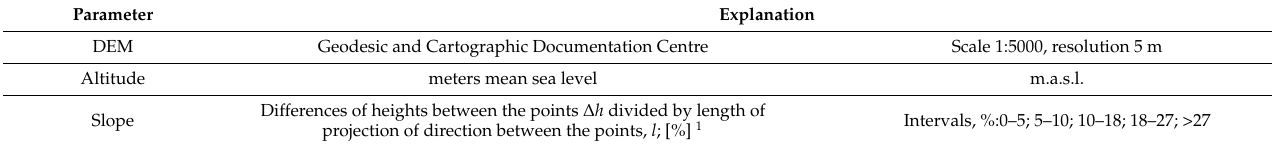
Table 1. Description of parameters used in coefficient wetness model.